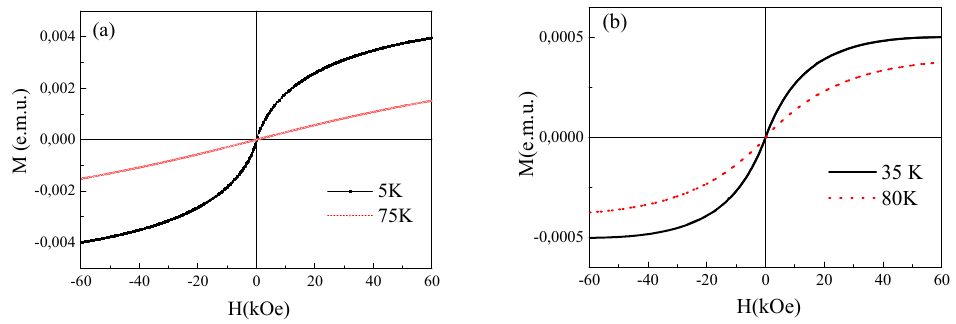
Figure 26. Magnetization curves, M (H), in as-prepared ( a ) and annealed at 400 °C for 10 h. ( b ) Cu 90 Co 10 sample measured at different temperatures.